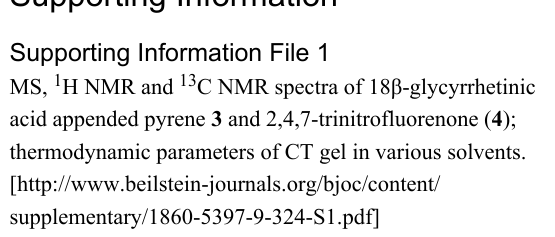
DMSO- d 6 ; mass spectrometry was measured on a Micromass QTOF and Finnigan TSQ spectrometer in positive mode; circular dichroism spectra were performed on JASCO J-815 CD spectrometer; scanning electron microscopy (SEM) images were performed on a Variable Pressure Tescan Vega3 SBU; optical micrographs were performed on a Olympus CKX41